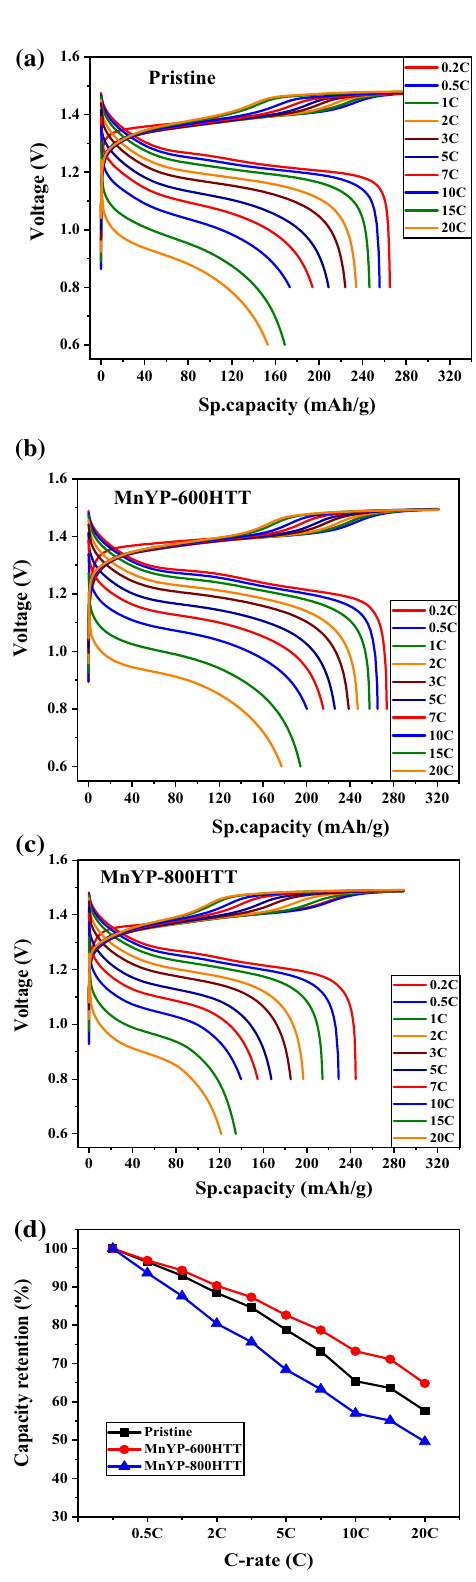
Figure 12. Rate capability test of Pristine, Mn-doped MnYP-600HTT and MnYP-800HTT under different